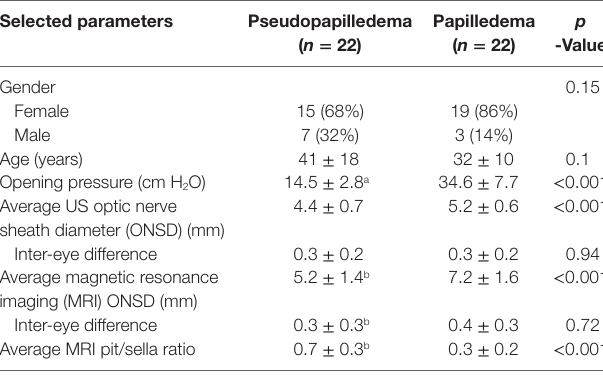
TaBle 1 | Comparison of selected parameters for patients with pseudopapilledema and those with papilledema from idiopathic intracranial